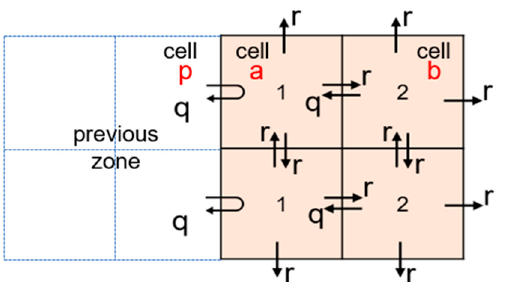
Figure 5. Inter-cell mobility model in a zone in 1ZR when a UE moves from the zone in the left ( n = 4).